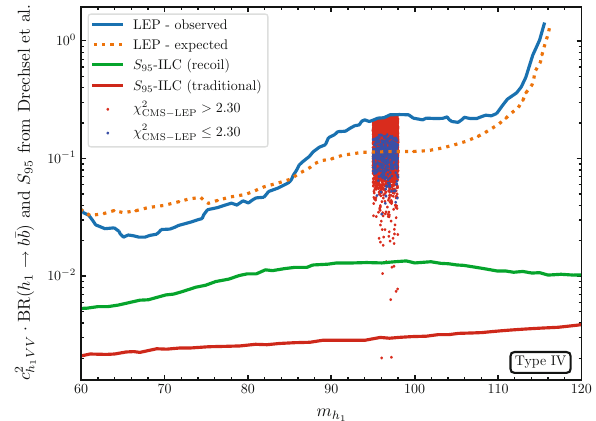
Fig. 13 The 95% CL expected (orange dashed) and observed (blue) upperbounds ontheHiggsstrahlungproductionprocesswithassociated decay of the scalar to a pair of bottom quarks at LEP [9]. Expected 95% CL upper limits on the Higgsstrahlung production process normalized to the SM prediction S 95 at the ILC using the traditional (red) and the recoil technique (green) as described in the text [100]. We also show the points of our scan in the type II scenario which lie within (blue) and outside (red) the 1 σ ellipse regarding the CMS and the LEP excesses